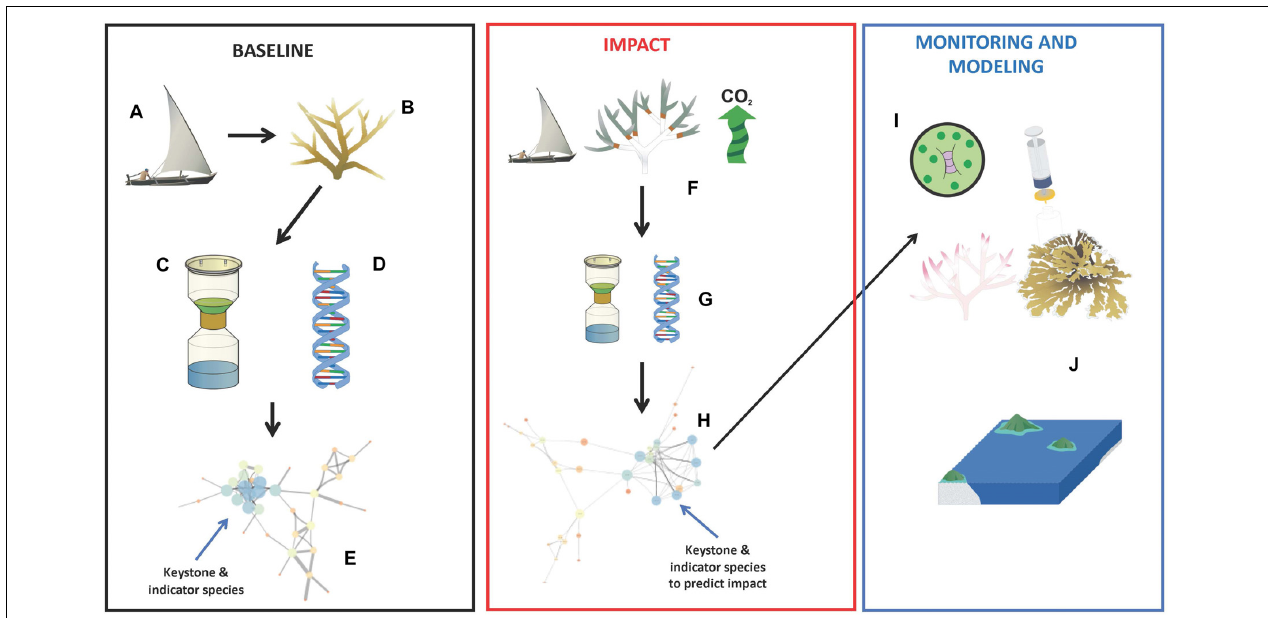
FIGURE 2 | Workflow for citizen science driven monitoring of ocean health using microbes. Citizen oceanographers (A) sample ocean habitats, represented here by a healthy coral (B) . Microbes are harvested from seawater on a filter (C) which then undergoes metagenomic sequencing (D) to profile the abundance of microbial species. This data is converted into a network analysis (E) which allows high-resolution metrics of microbial diversity and determines “keystone” species indicative of the baseline habitat at the time of sampling. Further sampling following ecosystem impacts (F) and replicated sample processing (G) allow robust comparison of changing microbiota (H) relative to the baseline. Specific organisms indicative of ecosystem change can then be further monitored using cheaper and simpler tools (I) to model ocean health (J) . Images courtesy of the Integration and Application Network, University of Maryland Center for Environmental Science (ian.umces.edu/symbols/